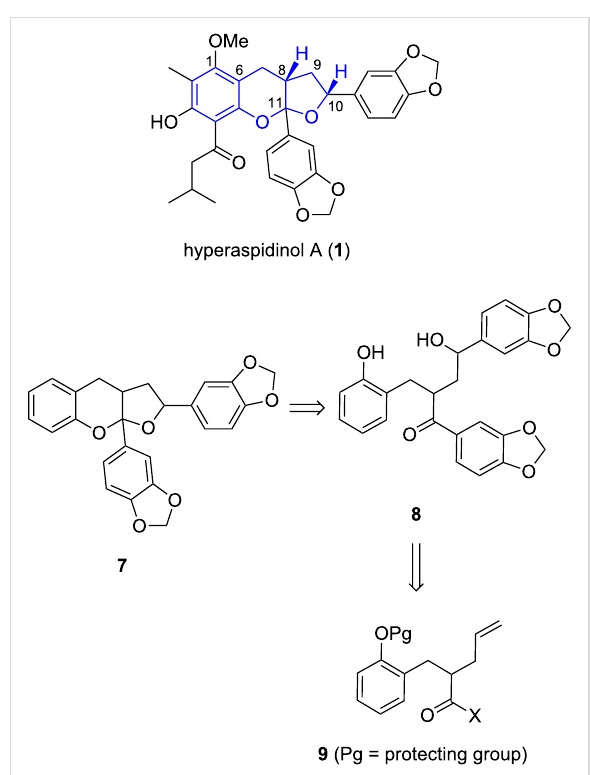
Figure 2: Hyperaspidinol A ( 1 ), target compound 7 and proposed precursors.